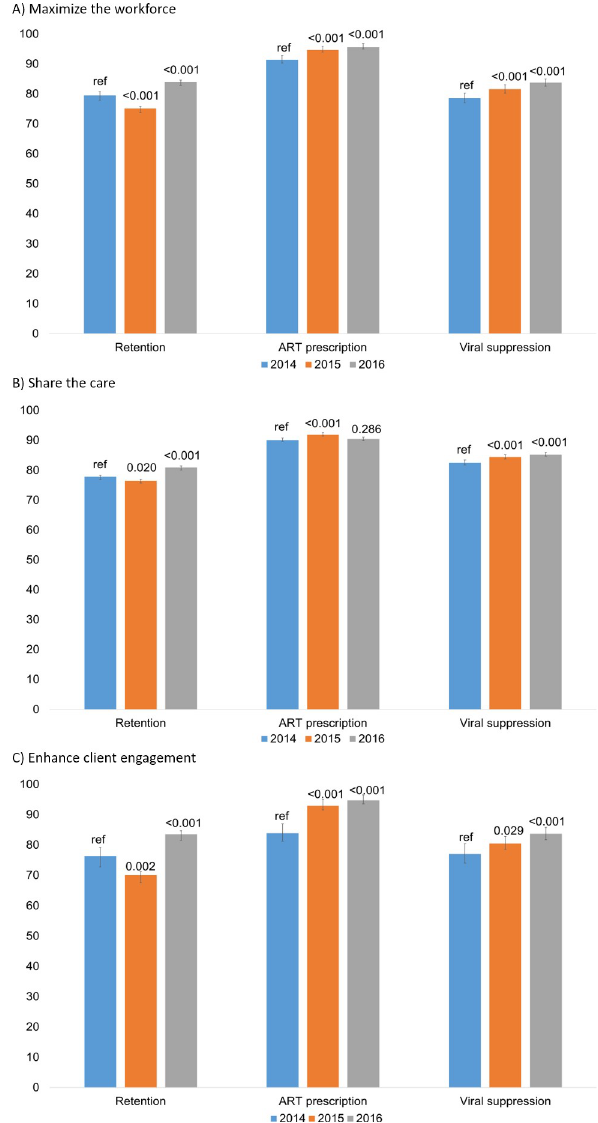
Fig 3. Changes in care continuum outcomes over time for demonstration project sites implementing each practice transformation approach. ART, antiretroviral